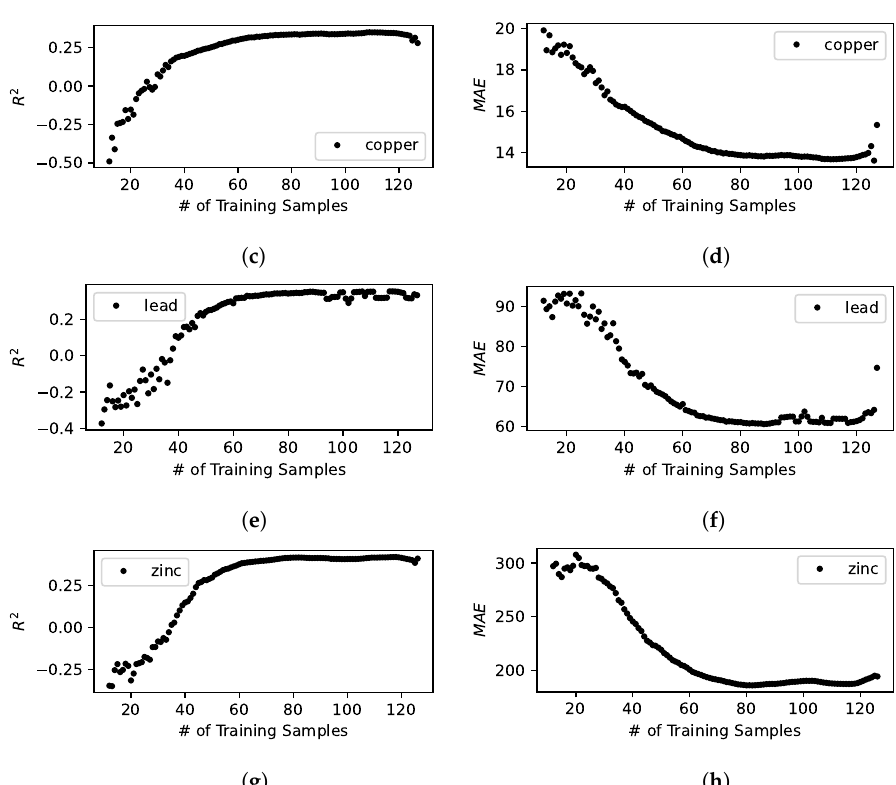
Figure 3. Standalone spatial interpolation model built with active learning. The figures show R 2 and MAE for predicted heavy metal concentrations on the evaluation data set. ( a ) R 2 for interpolated cadmium concentration; ( b ) MAE for interpolated cadmium concentration; ( c ) R 2 for interpolated copper concentration; ( d ) MAE for interpolated copper concentration; ( e ) R 2 for interpolated lead concentration; ( f ) MAE for interpolated lead concentration; ( g ) R 2 for interpolated zinc concentration; ( h ) MAE for interpolated zinc concentration.